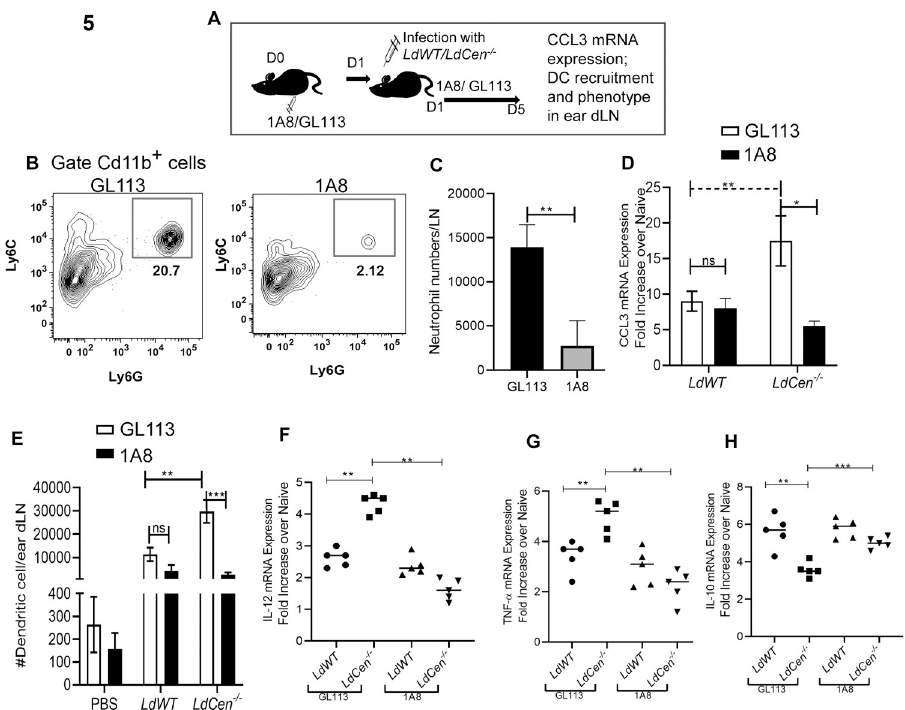
Fig 5. Neutrophil depletion abrogates CCL3 generation, DC recruitment in LdCen -/- infected mice ear dLN: recruited DC’s exhibit anti-inflammatory phenotype. (A) Schematic diagram showing experimental scheme for neutrophil depletion and subsequent experiments. ( B, C ) Representative plots and bar diagram showing mean total number of neutrophils per lymph node on day 5 in the GL113 or 1A8 treated mice. Data are pooled from three independent repeats and are shown as means ± SD that all yielded similar results (n = 6) �� p < 0.005. (D) RT-PCR analysis of total RNA isolated from draining lymph nodes of GL113/1A8 treated infected mice at 5d post infection as described in Materials and Methods. Normalized expression levels of CCL3 were estimated. Data are presented as fold change from uninfected naive mice. The data represent the mean values ± SD of results from 3 independent experiments that all yielded similar results (n = 6). �� p < 0.005. (E) Changes in the total number of DCs per ear dLN. Values shown are the mean numbers of cells per ear dLN ± SD of results. Six ear dLN and pooled data from three independent experiments (n = 6). �� p < 0.005; ��� p < 0.0005 between the groups. (F, G, H) DCs from GL113 /1A8 treated LdWT and LdCen -/- infected mice ear dLN were flow sorted and were subjected to RNA isolation as described in Materials and Methods. Isolated total RNA was reverse transcribed and the expression of mRNA encoding cytokines (IL-12, TNF-a, IL-10) was evaluated by qPCR. The data were normalized to GAPDH expression. The data represent the mean values ± SD of results from 3 independent experiments that all yielded similar results (n = 5). �� p < 0.005; ��� p < 0.0005 between the